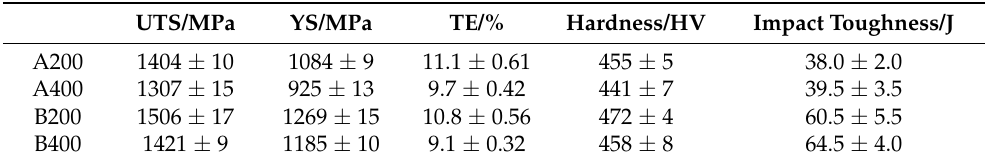
Figure 8. Stress–strain curves of different samples. Table 1. Mechanical properties of different samples subjected to different isothermal holding times.